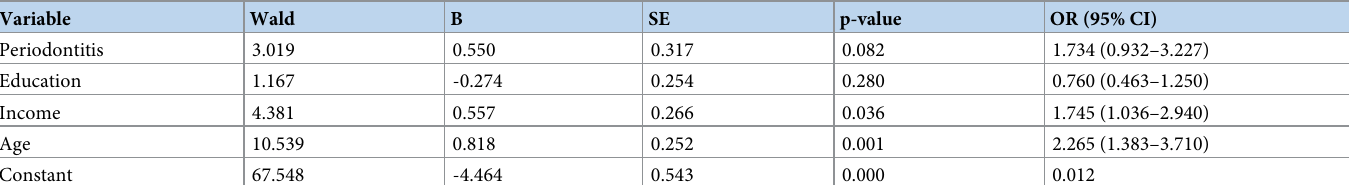
Table 3. Results from logistic regression analysis on periodontitis vs . breast cancer. Walds chi-sqare and p-value, odds ratio and 95 percent confidence interval (CI). Variable Wald B SE p-value OR (95% CI) Periodontitis 0.263 Constant